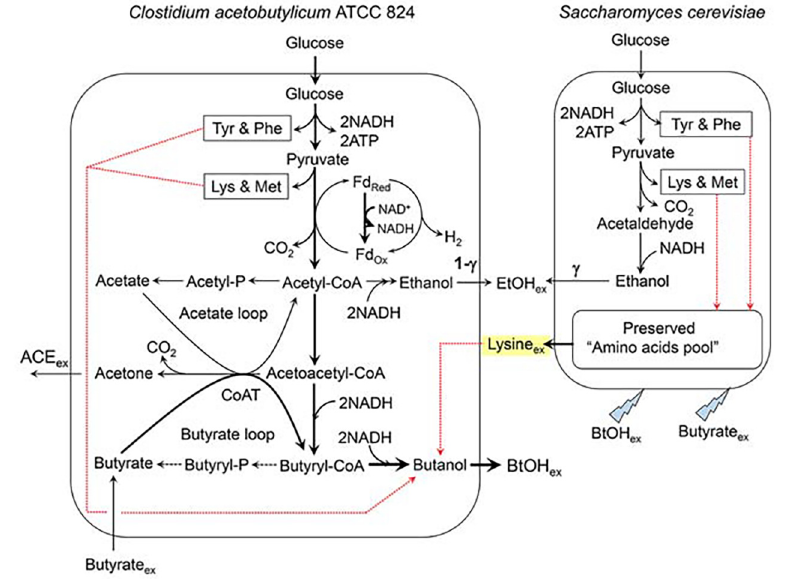
Fig 5. Simplified metabolic network map indicating C . acetobutylicum and S . cerevisiae metabolisms. Bold solid lines: enhanced metabolic fluxes; broken lines: weakened metabolic fluxes; dotted red lines: accumulation/secretion and assimilation/utilization directions of the amino acids favorable for butanol synthesis by C . acetobutylicum and C . acetobutylicum